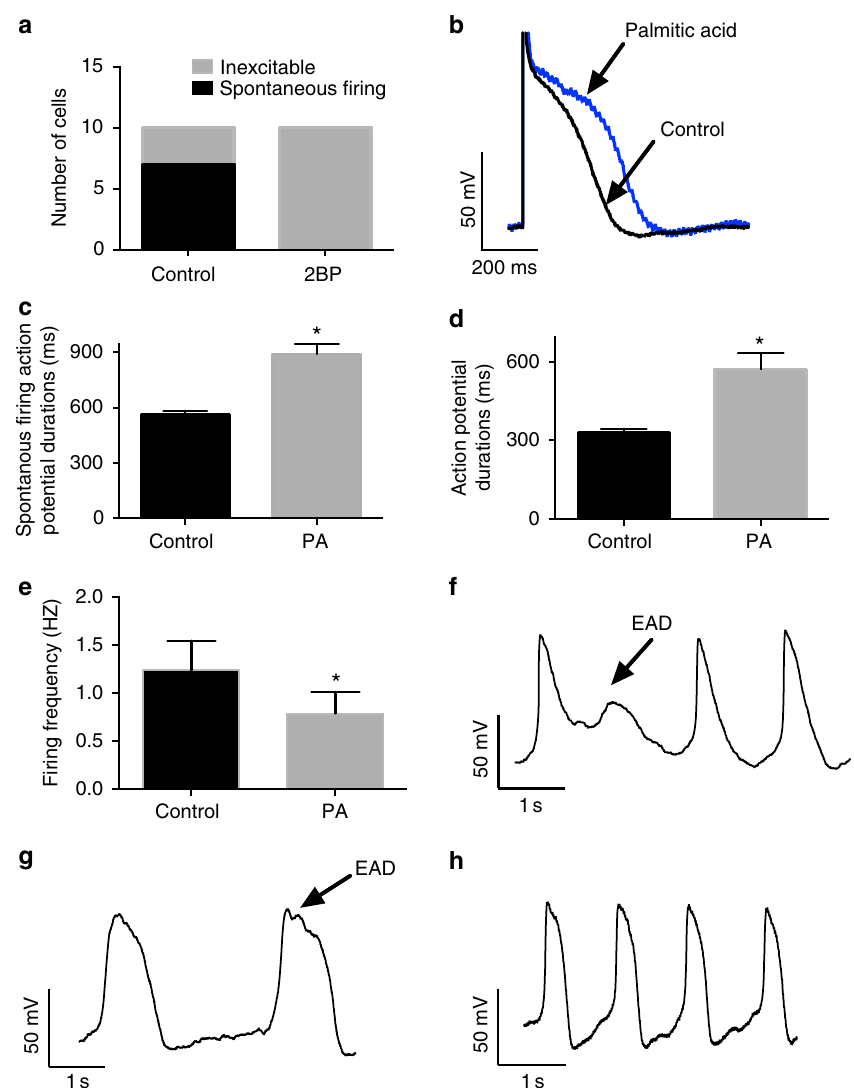
Figure 1 | Palmitoylation alters cardiomyocytes excitability. All data are shown as mean ± s.e.m. ( a ) Number of cells that are excitable myocytes. Only cells that exhibited inward sodium current were analysed. Seven out of 10 cells (70%) in the control group fired spontaneous action potentials. None of the 10 cells in the 2-Br-palmitate (2BP) group were able to generate action potentials. ( b ) Representative action potential traces of cardiomyocytes with (blue) and without (black) palmitic acid treatment. Palmitic acid(PA) treatment increases the APD. ( c ) Averaged APD measurements from the spontaneous firing myocytes. Averaged APD is 563ms in the control group and 890ms in the palmitic acid treatment group. The difference is statistically significant ( n ¼ 5, P ¼ 0.001 and unpaired Student’s t -test). ( d ) Averaged APD measurements of single action potential waveform elicited by 2ms stimulus pulses. APD is 330.4ms in the non-treatment group and 572.8ms in the palmitic acid treatment group. The difference is statistically significant ( n ¼ 5, P ¼ 0.01 and unpaired Student’s t-test). ( e ) Firing frequency in control group and palmitic acid treatment group. The firing frequency is 1.2 ± 0.10 in the control group and 0.79 ± 0.11 in the palmitic acid treatment group. The difference is statistically significant ( n ¼ 8, P ¼ 0.03 and unpaired Student’s t -test). ( f – g ) Spontaneous action potential recorded from palmitic acid treatment group. EAD phenomenon is indicated with arrows. The results are representative of at least three independent experiments. ( h ) Cardiomyocyte spontaneous action potential generated under non-treatment condition. The action potential firing is in a constant rate with no ectopic firing